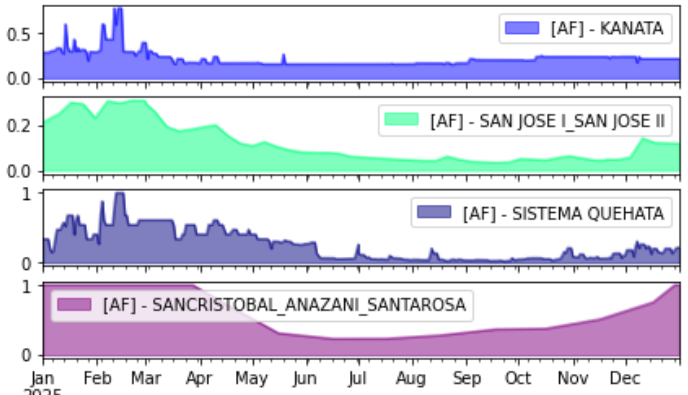
Figure 11. Hydro run-of-river Resources Availability Factor (year 2025) [35].